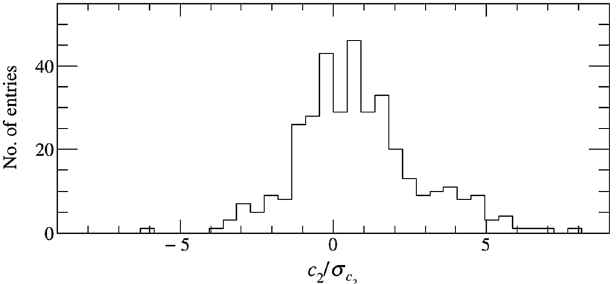
FIG. 13. Statistical distribution of c 2 = σ quadratic parameter c 2 to its error, for the second time interval Δ T 2 for all 359 cycles, which yields c 2 =